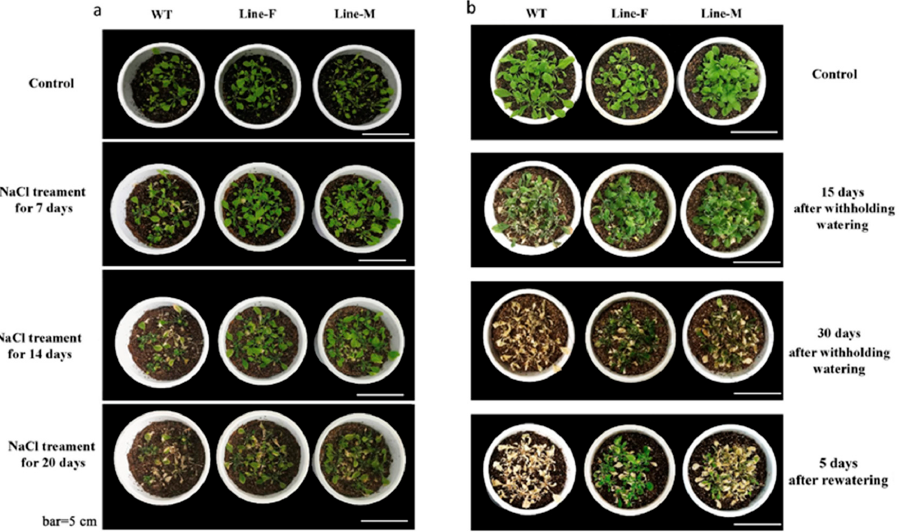
Figure 4. Morphological responses of wild-type (WT) and transgenic lines to salt ( a ) and drought treatments ( b ).